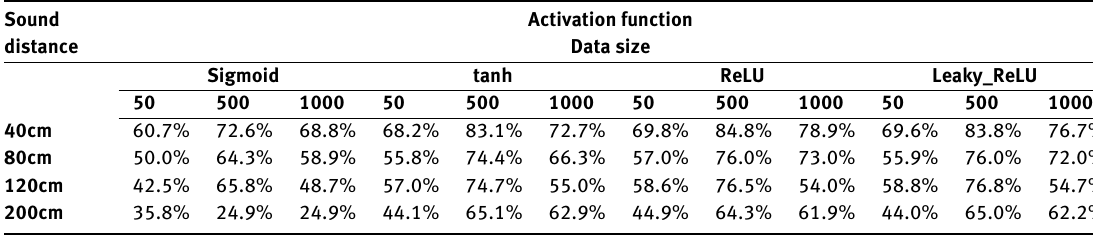
Table 8: The accuracy of the identification of different data sizes in common rooms.